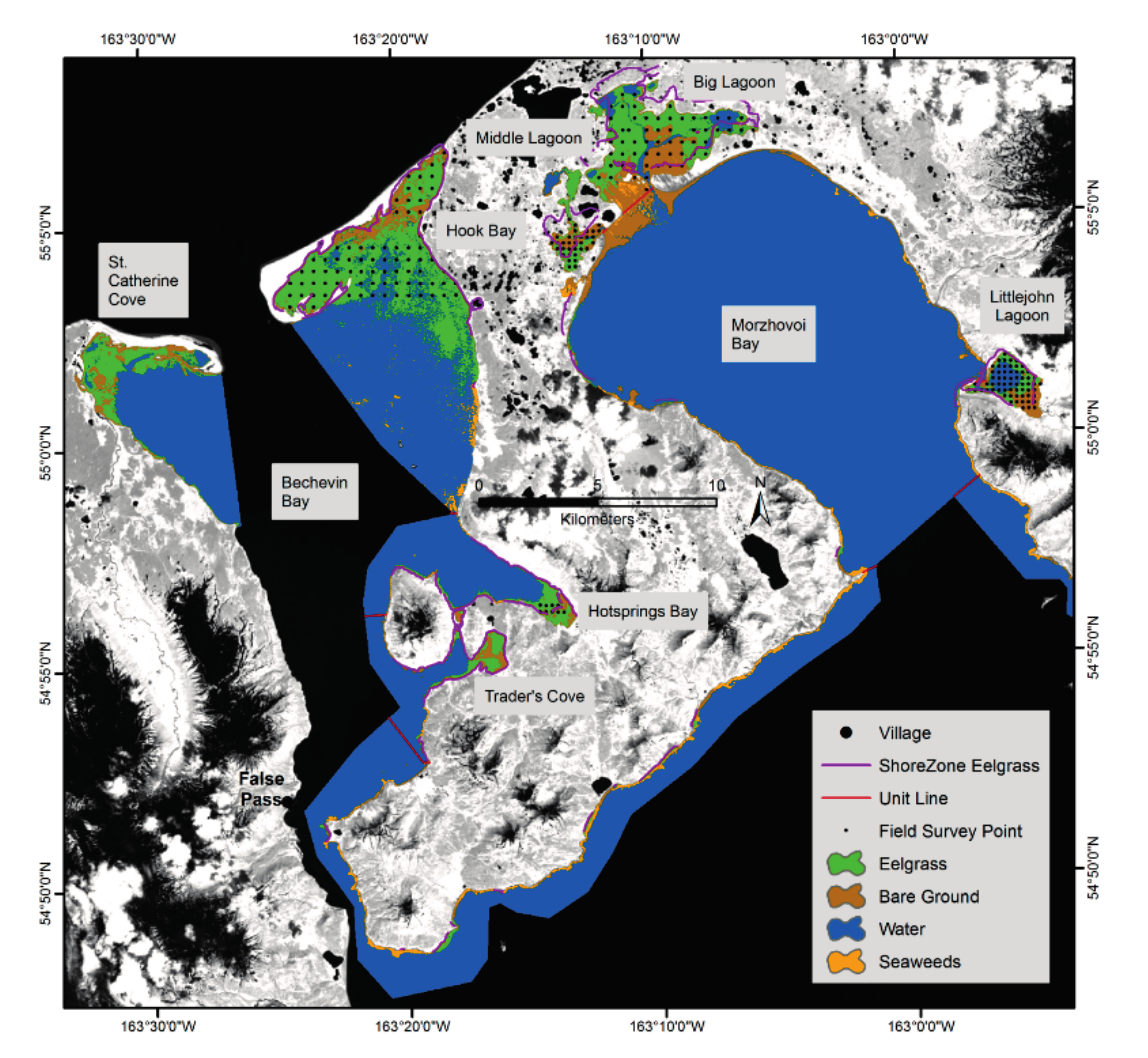
Figure 7. Distribution of eelgrass and other habitats as derived from Landsat imagery (displayed as a black/grayscale backdrop) and field survey points in Bechevin and Morzhovoi bays. In areas lacking field survey points, ShoreZone data were used to differentiate between eelgrass and other